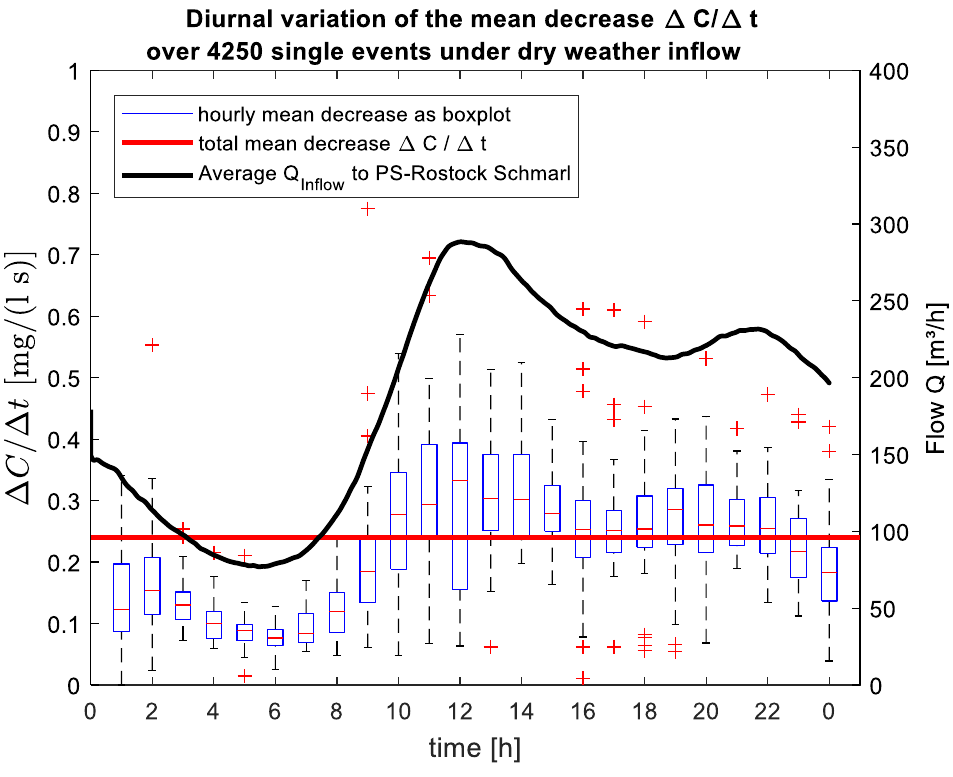
Figure 8. Diurnal variation of the mean decrease ∆ C /∆ t (boxplots) including total mean decrease over 4250 single settling events (red line) and the average Q inflow for dry weather conditions (black line).